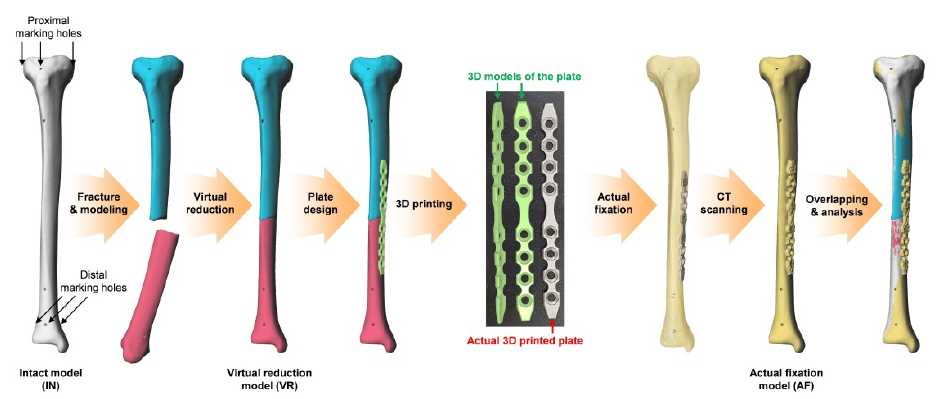
Figure 1. Overall experimental flow. Three-dimensional, (3D).